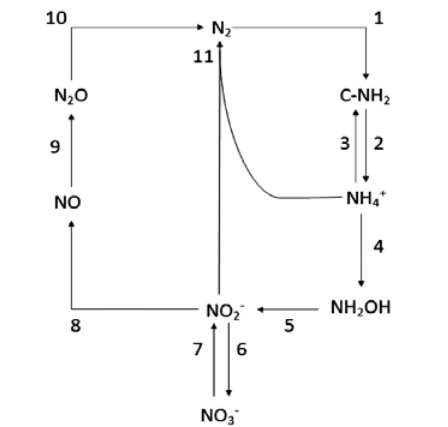
Fig. 1. The main nitrogen compounds transformation